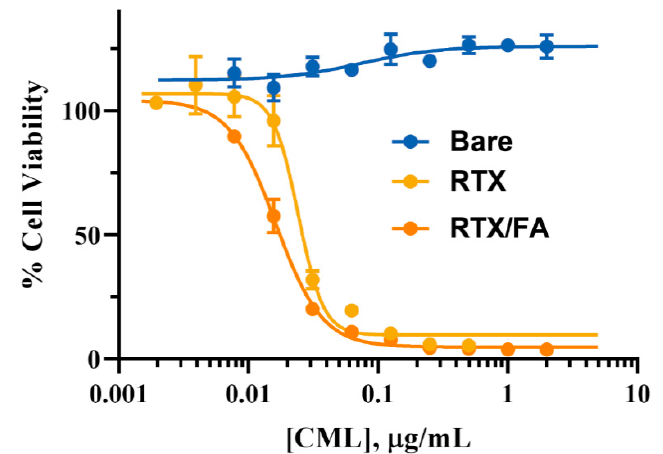
Figure 5. Cell viability of CT26 cells after 72 h exposure to various NPs. Toxicity is increased greatly in the formulations that contain RTX, with no observed toxicity in cells treated with the uncoated NPs.